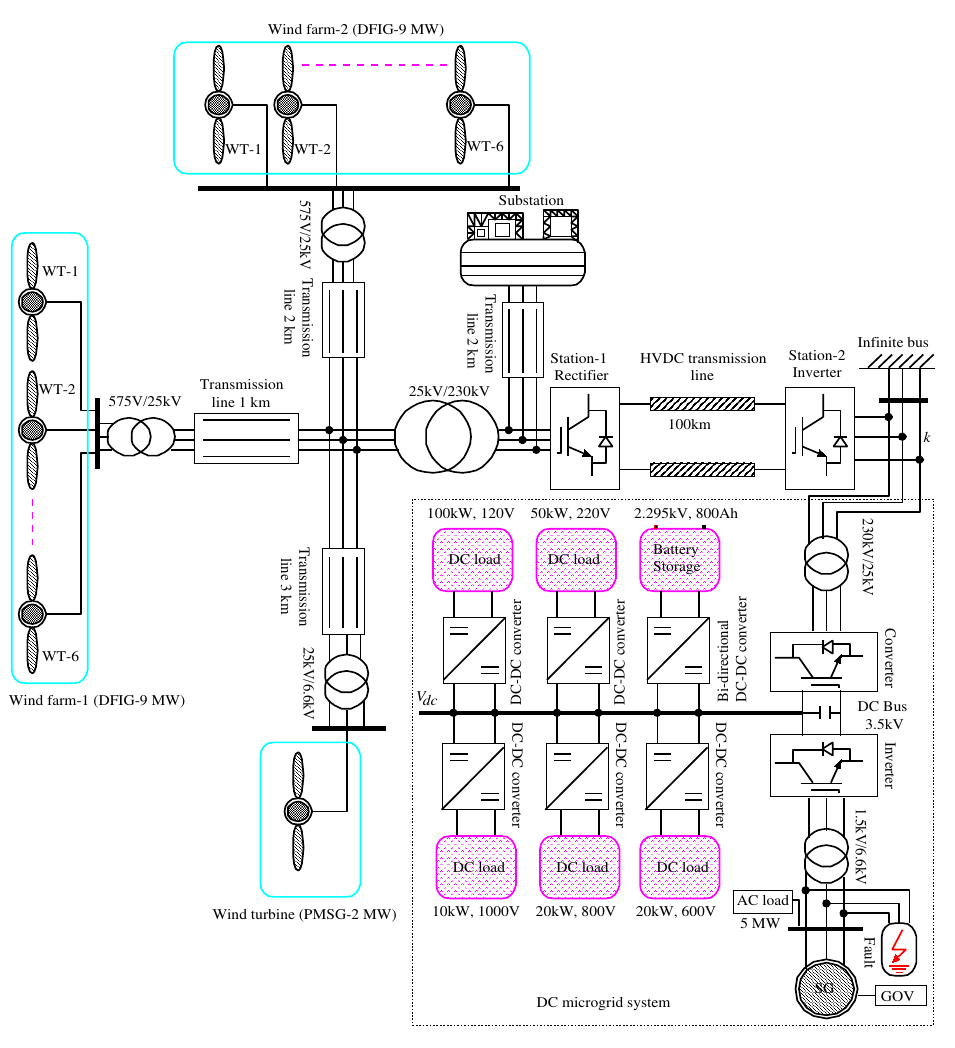
Figure 1. The proposed smart grid